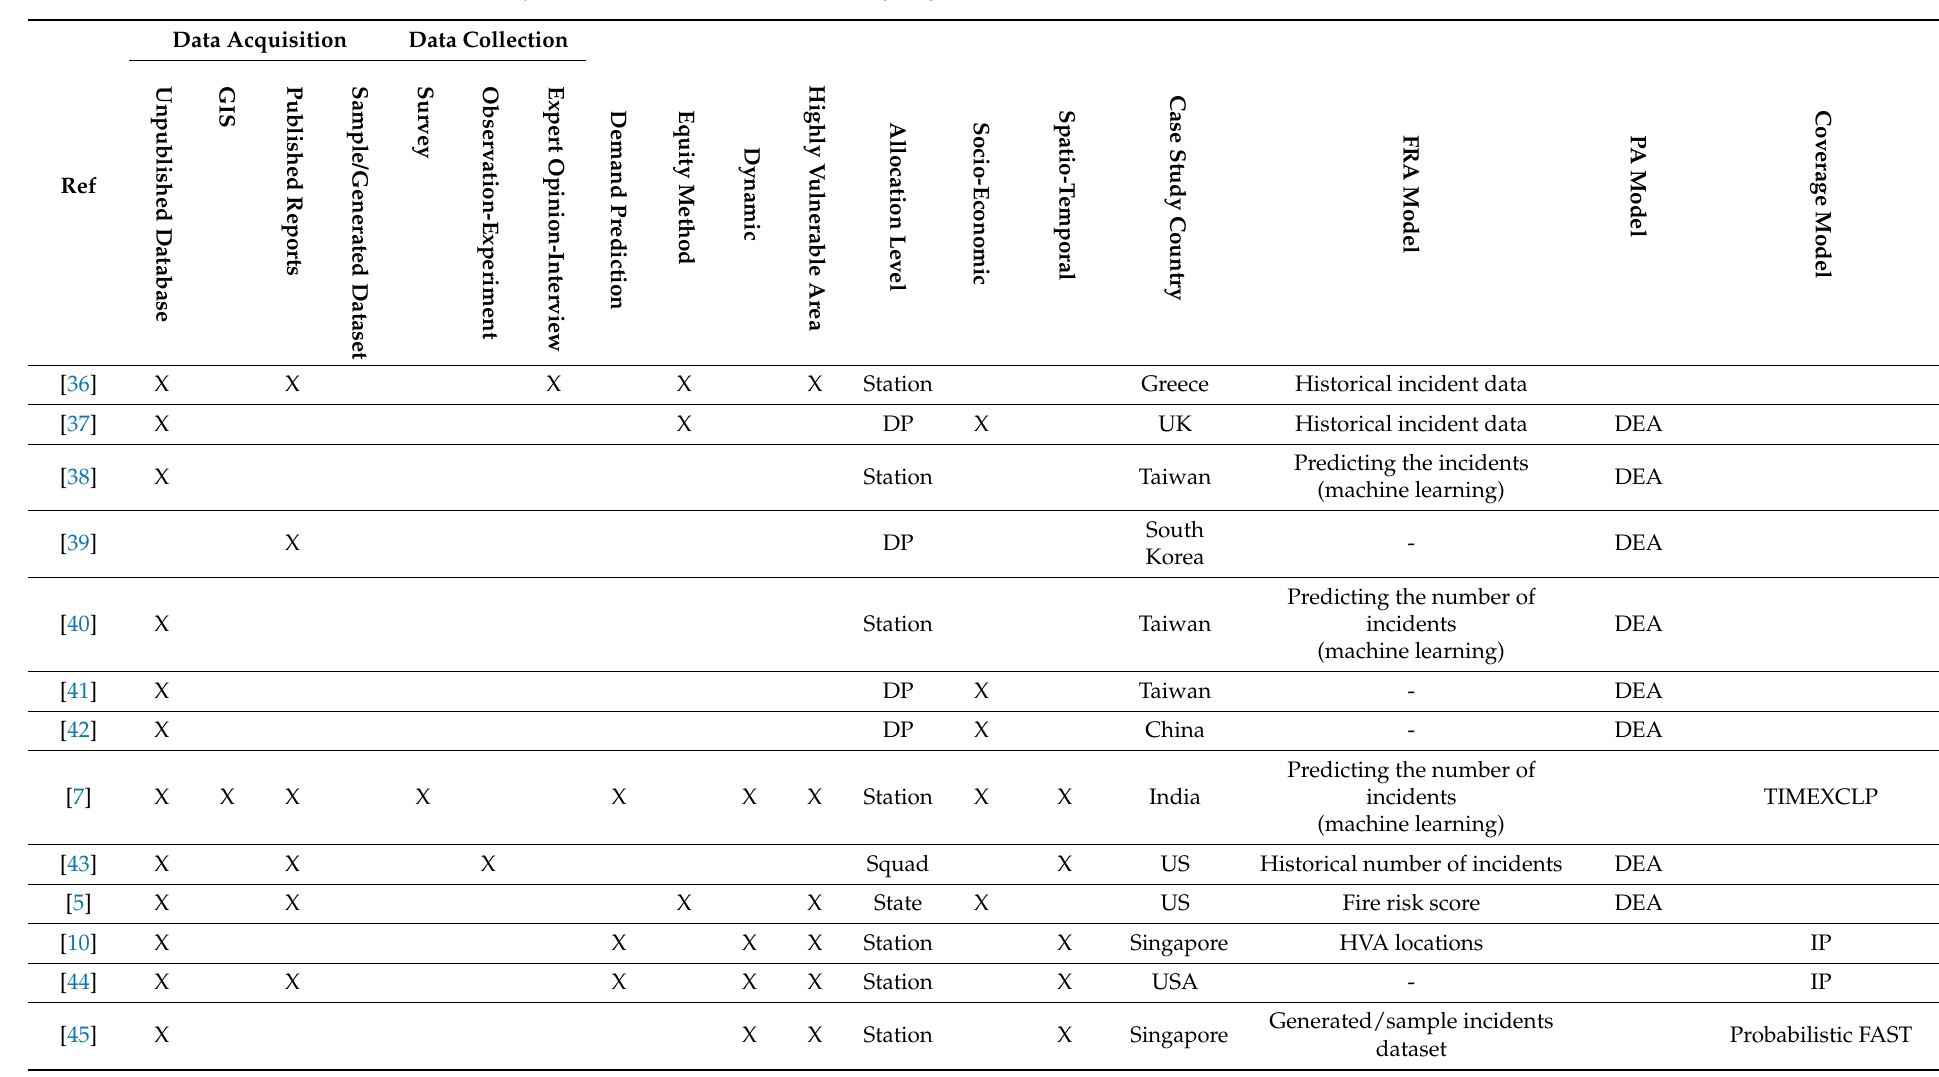
Table 2. Summary of the extracted codes in the coding